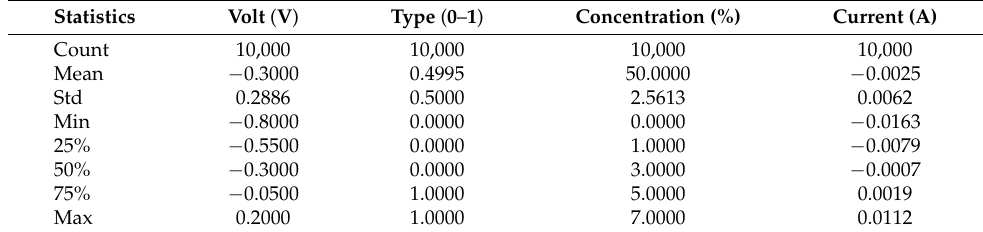
Table 3. Important statistical values of Dataset C.